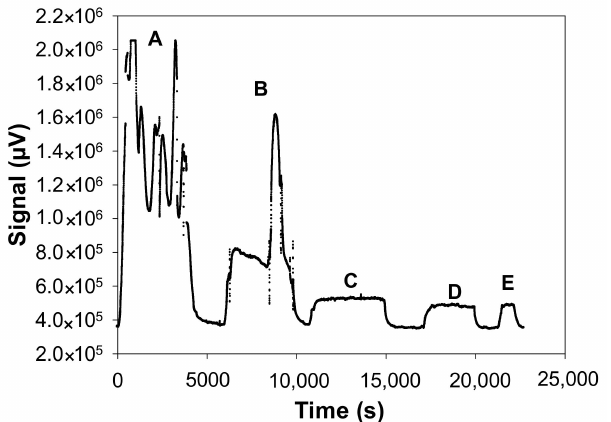
Figure 10. Raw fluorescence signal of the formaldehyde analyser measured with the 5 studied configurations: A: L = 20 cm, coiled; B: L = 14 cm, coiled; C: L = 14 cm, straight; D: L = 7 cm, straight; E: L = 3.5 cm, straight. The other parameters were fixed as follows: [HCHO] liq = 20 mg L − 1 , F gas = 50 mL min − 1 , T = 10.7 ◦ C, photomultiplier gain =